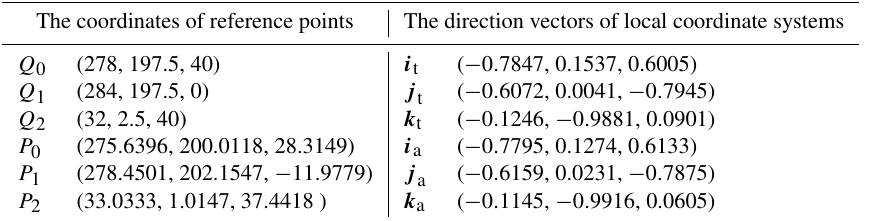
Table 1. The local coordinate systems of the rough matching. The coordinates of reference points